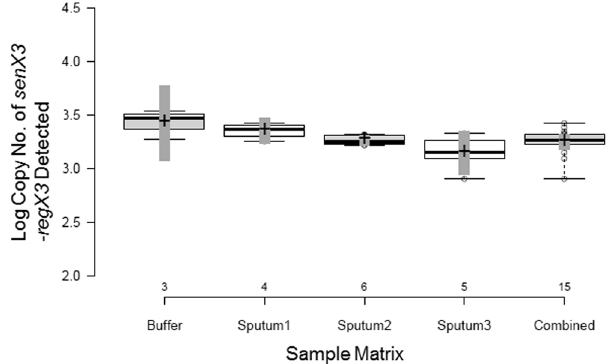
Figure 2. MTB DNA yield of XtracTB Assay is similar between buffer and 3 sputum specimens. Box and whisker plot of MTB yield from different specimen types: buffer, sputum 1, sputum 2, sputum 3, and all sputum results combined. Center lines show the medians; box limits indicate the 25th and 75th percentiles as determined by R software; whiskers extend to minimum and maximum values; crosses represent sample means; vertical dark gray bars indicate 95% confidence intervals of the means; data points are plotted as open circles. n = 3, 4, 6, 5, 15 sample points, respectively.